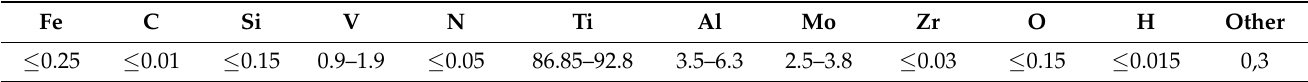
Table 2. Element composition of Ti-4Al-3Mo-1V alloy (wt%).